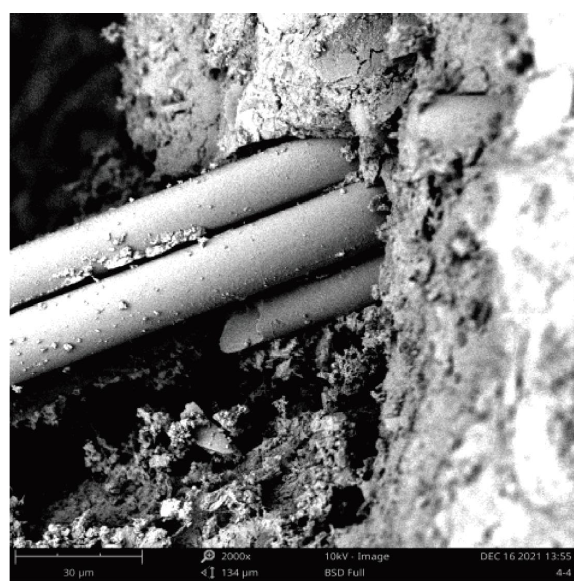
Figure 2: Microscopic view of chopped basalt fber. Table 1: Basalt fber performance index.